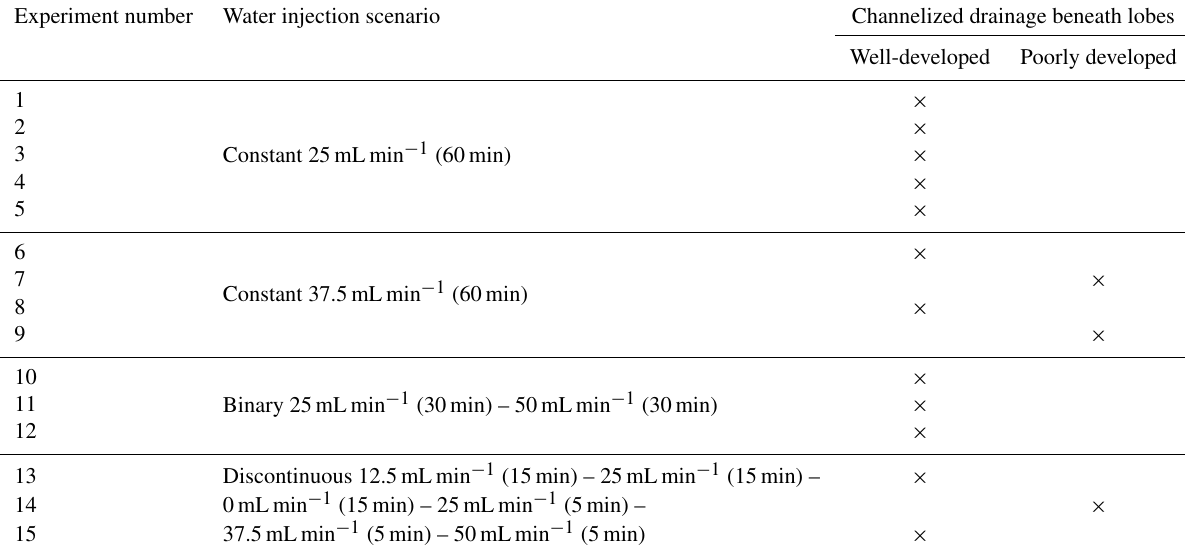
Table 1. Water injection scenarios and type of water drainage observed in each experiment. Experiment number Water injection scenario Channelized drainage beneath lobes